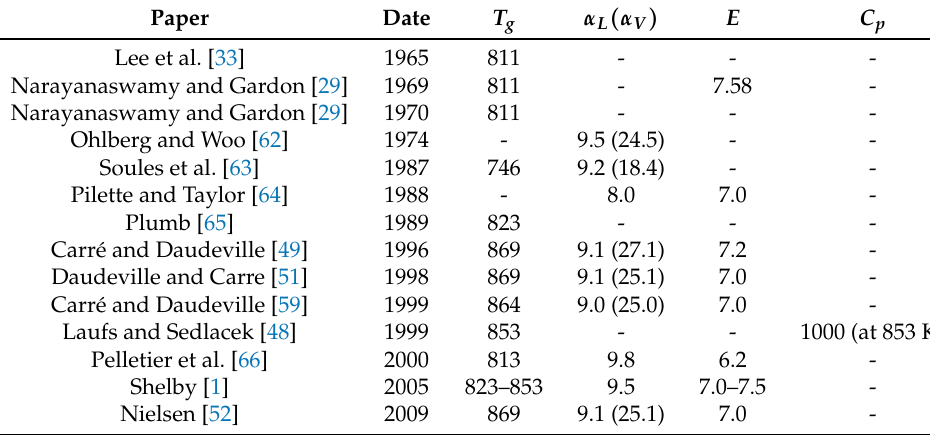
Table 2. Review summary of selected